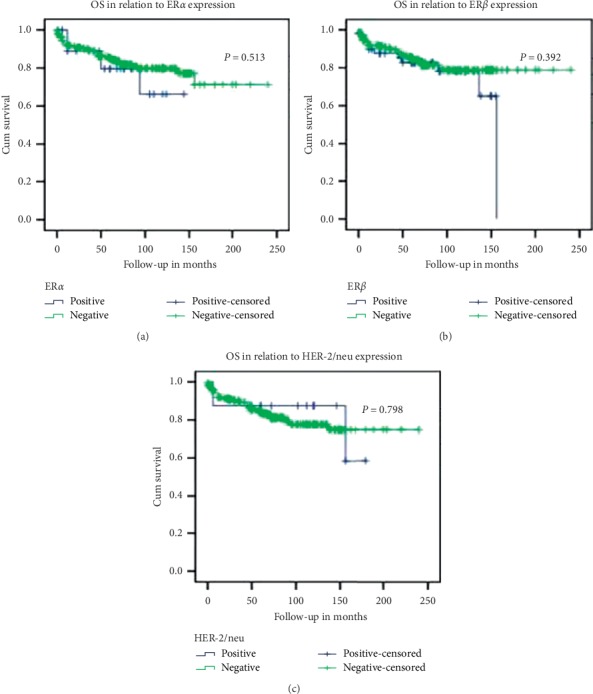
Overall survival in relation to (a) ERα, (b) ERβ, and (c) HER-2 expression.